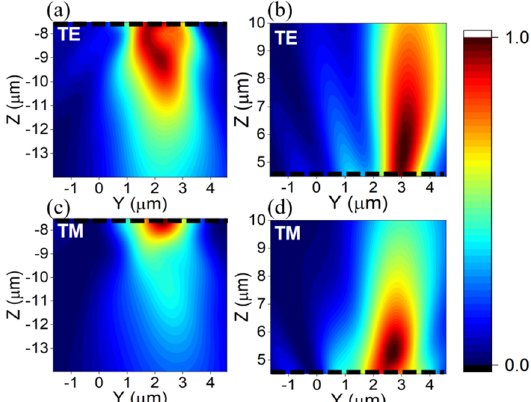
Figure 4. The normalized intensity of the Y − Z plane at the re fl ective and transmissive ends of the metasurface beam spli tt er under the incidence of x-polarized light at 1.55 µm wavelength demonstrates the de fl ection of the outgoing light. ( a ) The intensity of the Y − Z plane at the re fl ective end of the metasurface beam spli tt er under the incoming x-polarized light of 1.55 µm wavelength. ( b ) The